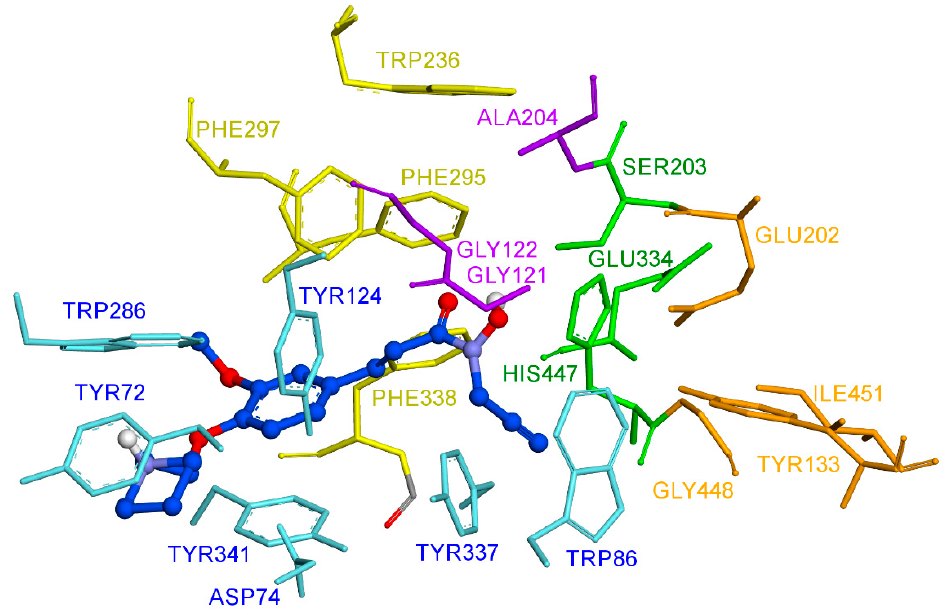
Figure 2. Binding mode of compound 4 in the active site of hAChE. Compound 4 is shown as a ball and sticks (carbon atoms in blue), and the side-chain conformations of the mobile residues are shown in light blue. The catalytic triad (CT) is colored green, the oxyanion hole (OH) is magenta, the choline-binding pocket is orange (except Trp86), the acyl-binding pocket (ABP) is yellow, and the peripheral aromatic site (PAS) is light blue.